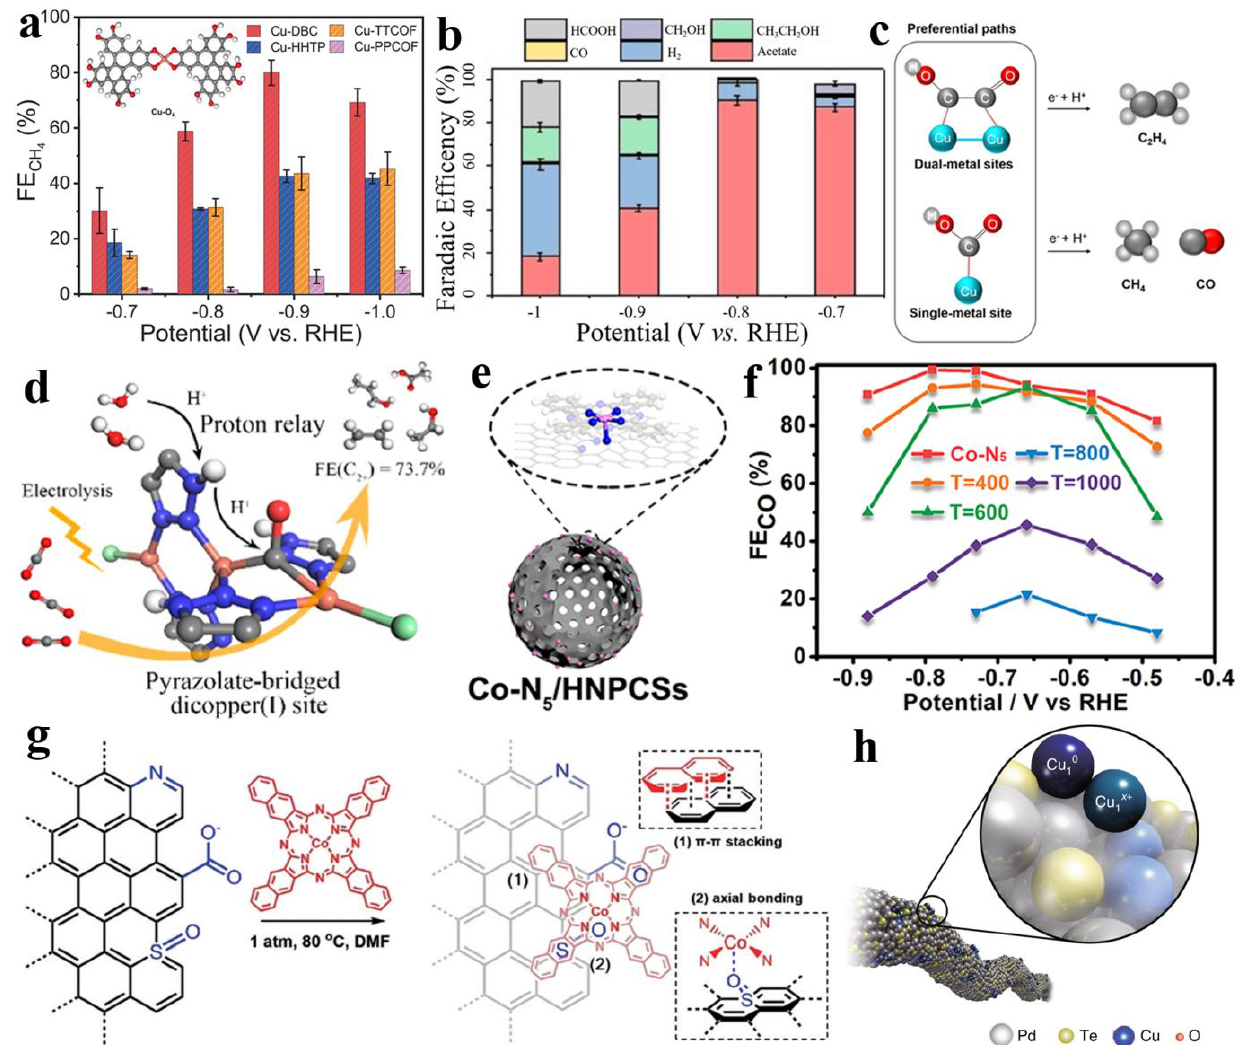
Figure 8. ( a ) Faradaic efficiencies of CH 4 for crystalline single-site Cu electrocatalysts. Reprinted with permission from ref. [57]. Copyright: (2021) Nature Publishing Group. ( b ) Faradaic efficiencies of